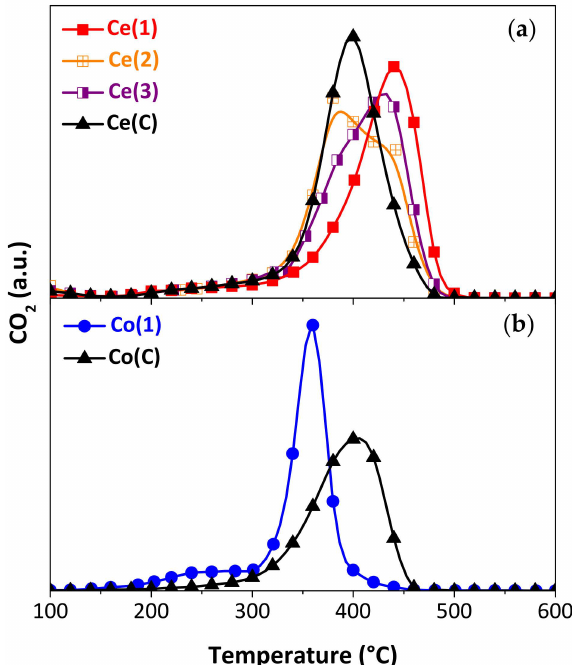
Figure 4. TPO curves using the catalytic synthesized particles (Table 1), and comparison with commercial nanoparticles (Ce(C) and Co(C)): ( a ) CeO 2 and ( b ) Co 3 O 4